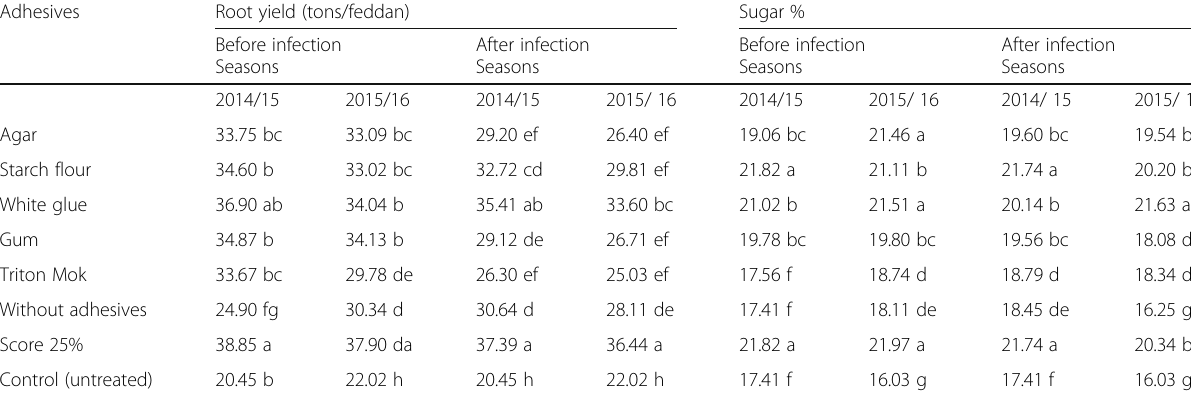
Table 3 Effect of foliar treatment with spore suspension of Penicillium frequentans on root yield and sugar percent of sugar beet under field conditions during 2014/15 and 2015/16 growing seasons Adhesives